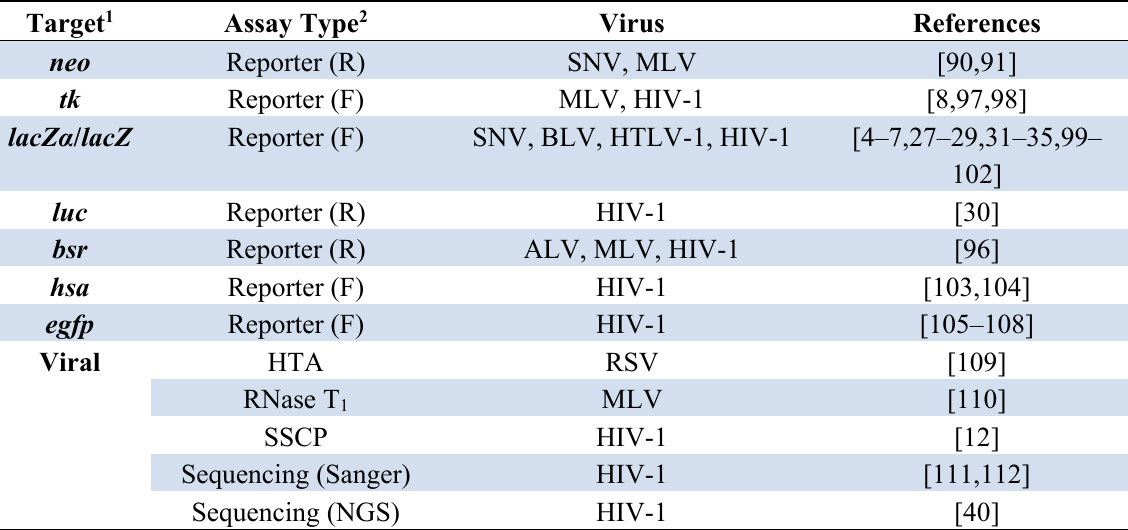
Table 1. Targets for analysis of retroviral mutagenesis.